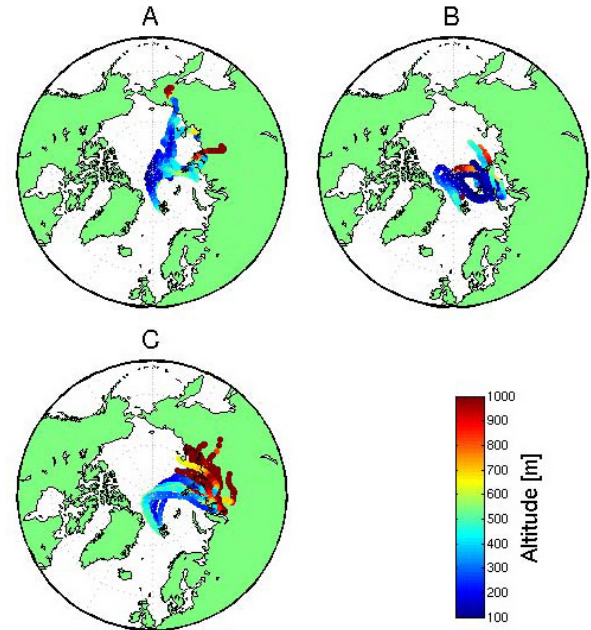
Fig. 4. 7-day back trajectories arriving in Ny- ˚Alesund during the strongest AMDEs in 2008 (GEM < 0.54ngm − 3 ) . (A) 24